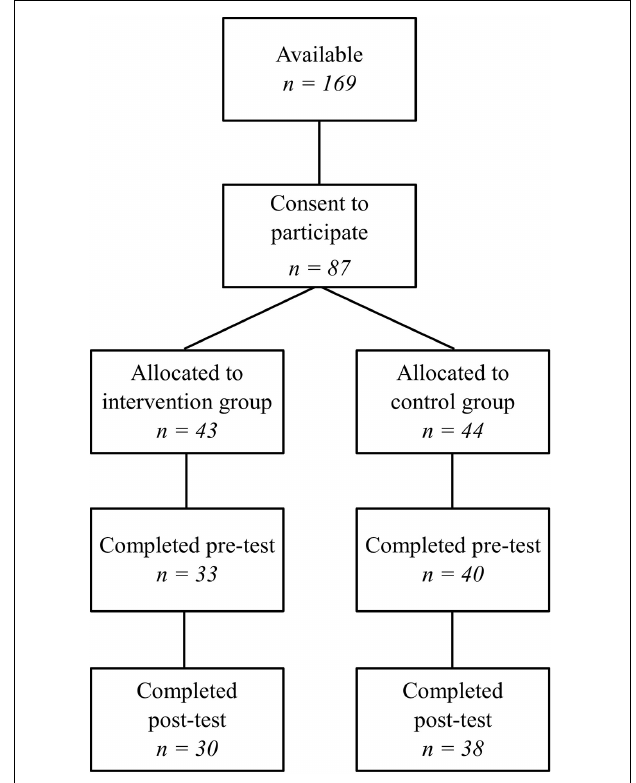
FIGURE 1 | CONSORT